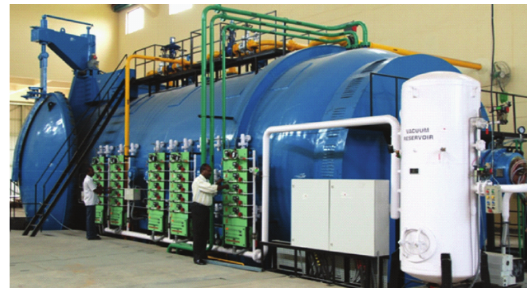
Figure 3: India’s largest aerospace autoclave with working space of 4.4m dia × 9m length at CSIR-NAL, Bangalore.